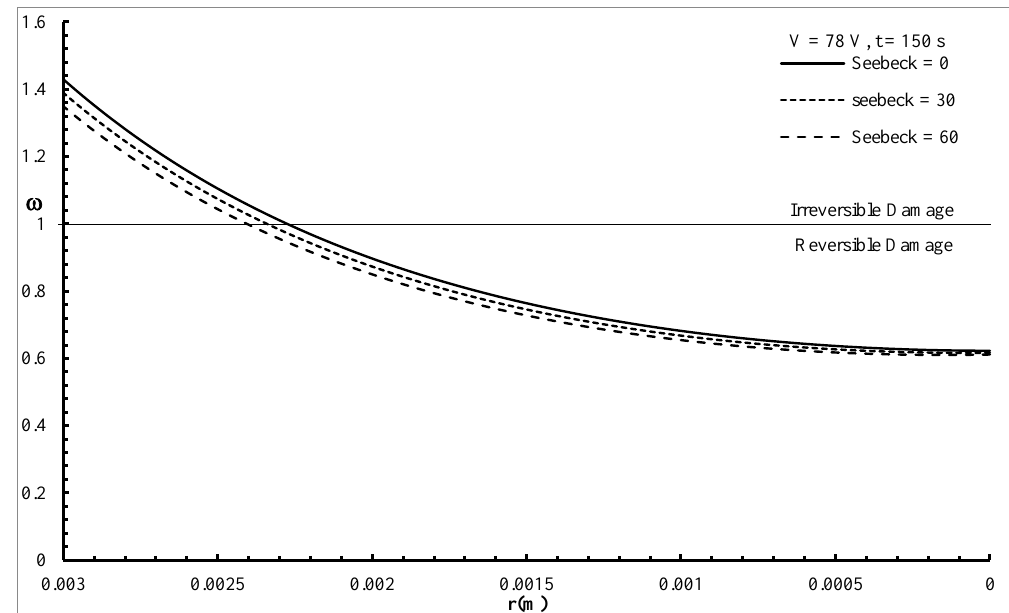
Figure 17 . The thermal damage distribution of myxoid liposarcoma tumor with various values of R   . the Seebeck coefficient when 75 e